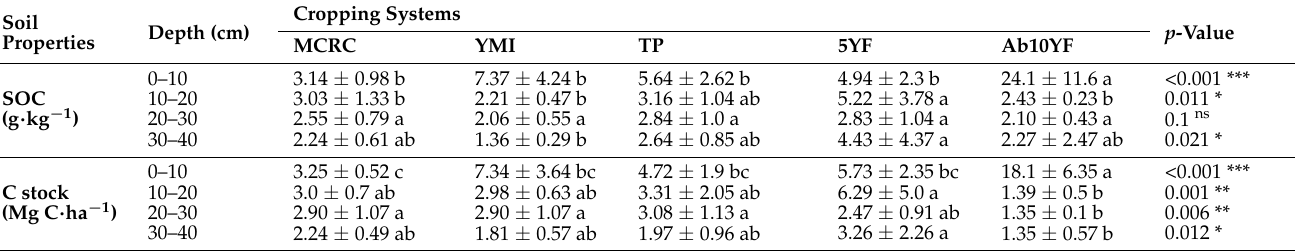
Table 3. Soil organic carbon content and carbon stock per soil depth